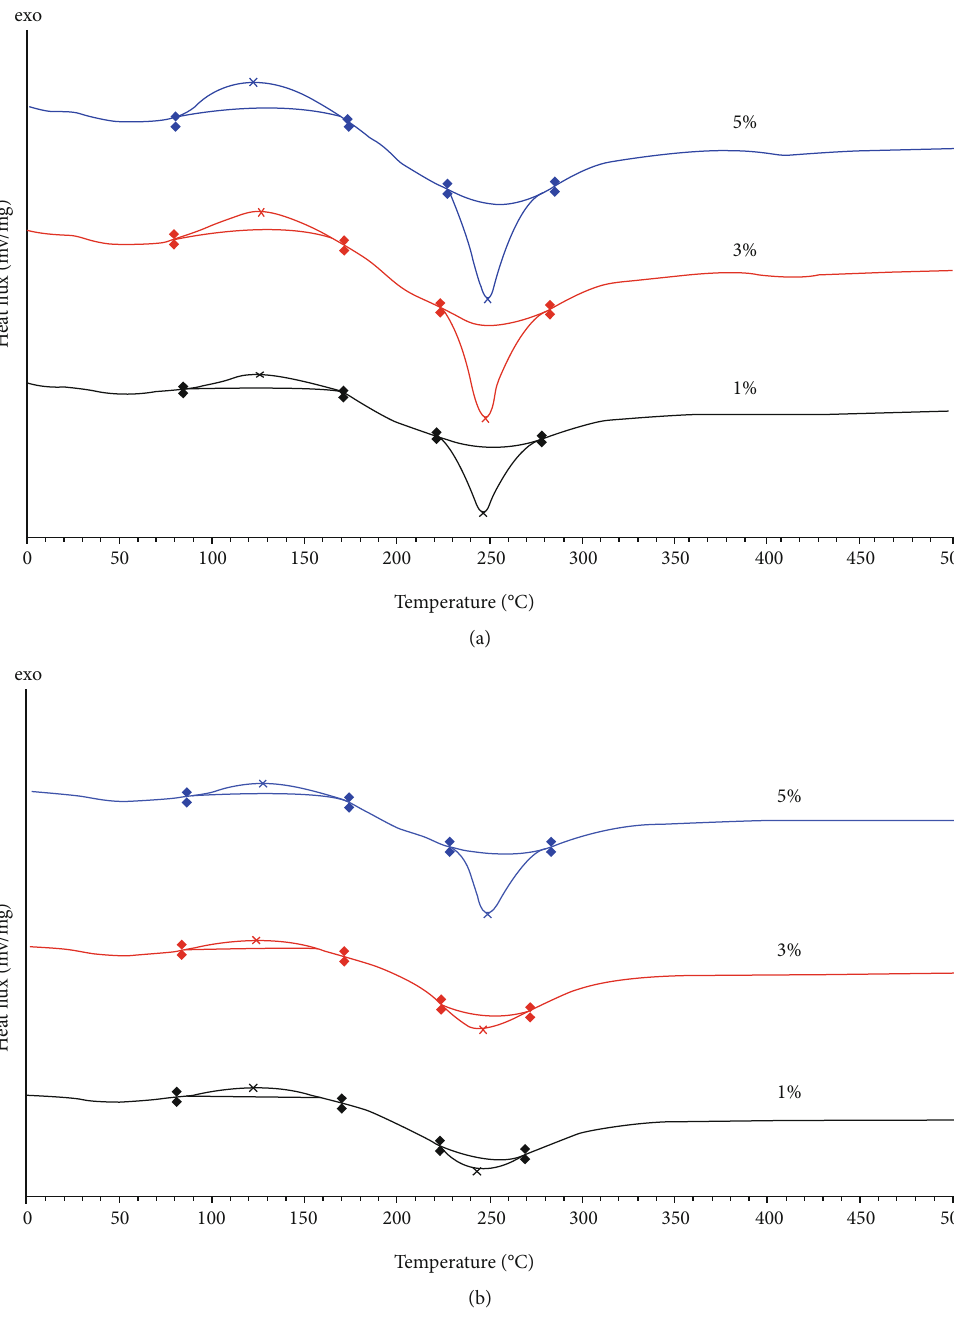
Figure 7. The antimicrobial activity of the fi lms containing dif- ferent concentrations of the leaf extract and gum on the activ-